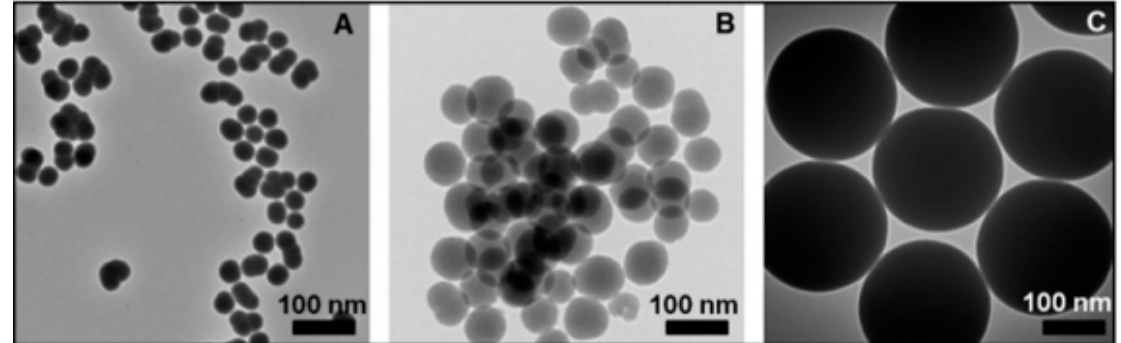
Figure 3. TEM images of SiC NPs at different reaction temperatures [44].